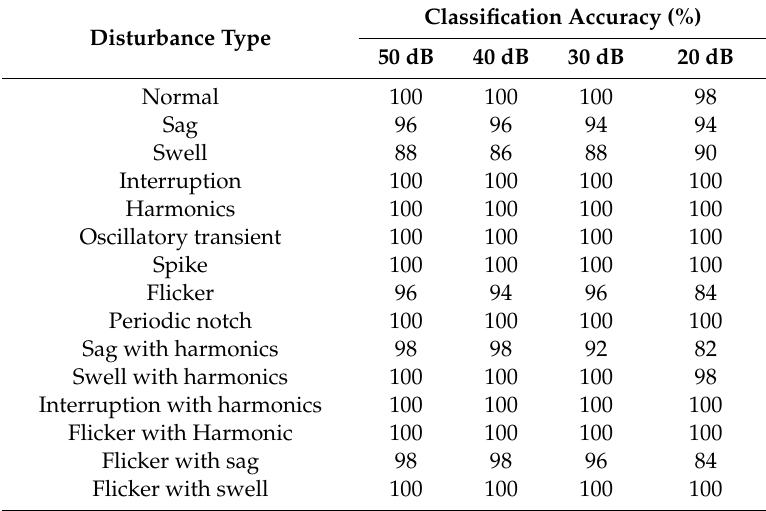
Table 6. Classification e ff ect of each disturbance type of PSO-H-ELM.